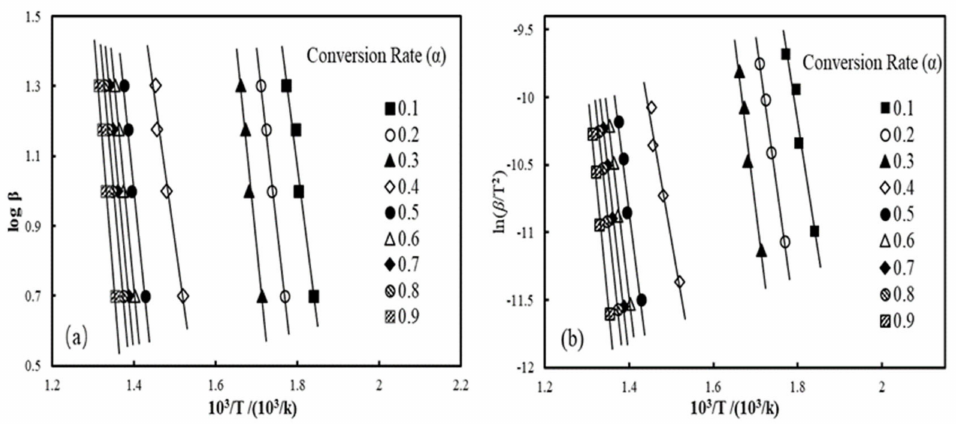
Figure 5. Iso-conversion plots of F-W-O method for B3 ( a ); example iso-conversion plots of the modified C-R method for B3 ( b